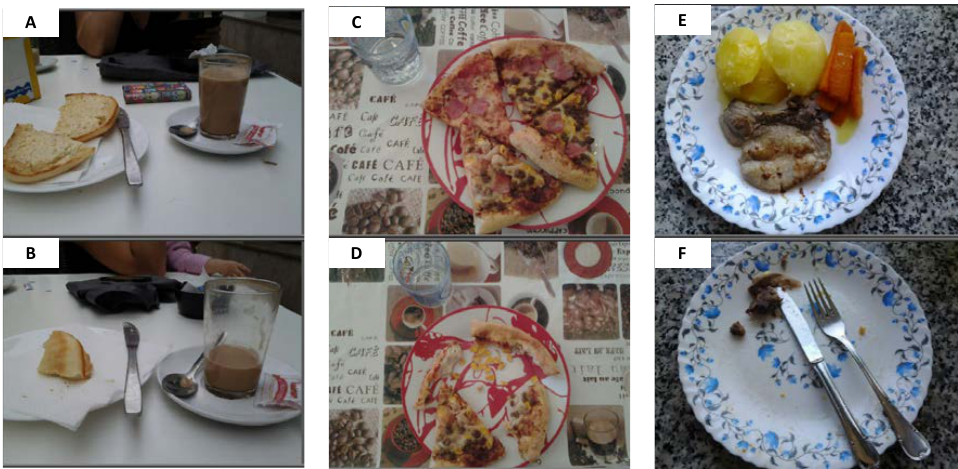
Figure 1. Selected examples of pictures taken by ANIBES study participants (before ( A , C , E ) and after consumption ( B , D , F )).